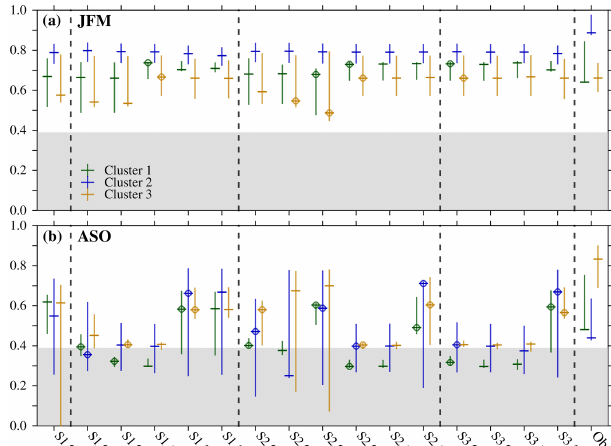
Figure 10. As in Fig. 7 but after detrending with a second-degree